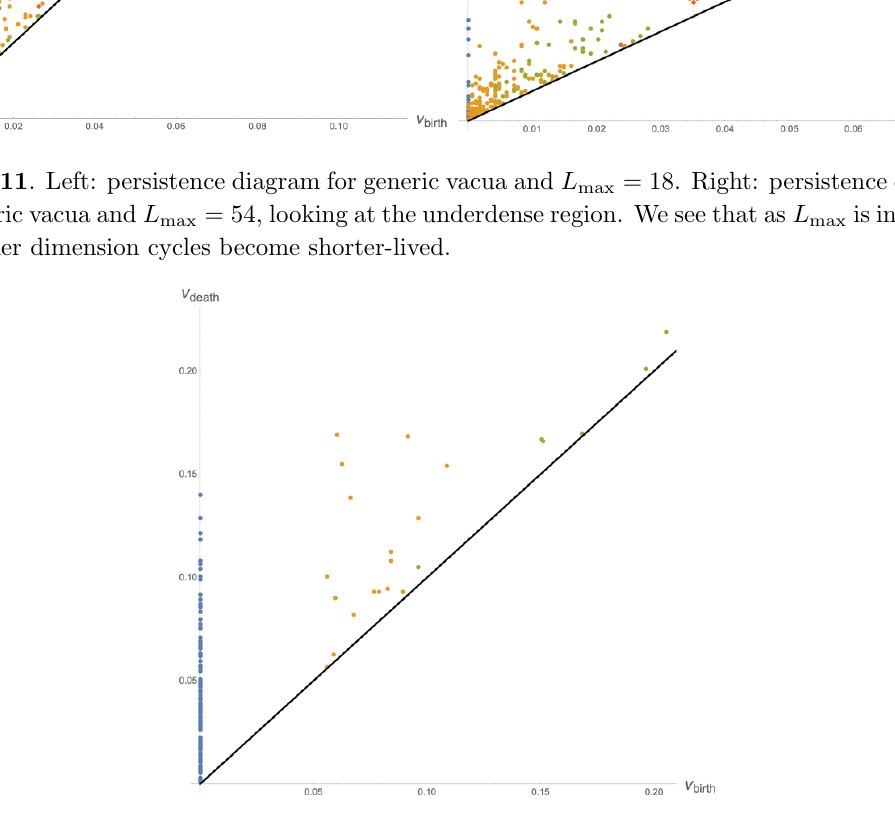
Figure 12 . Long-lived 1-cycles in the generic distribution of T 6 vacua. Here we used 150 landmark points for a subregion of the generic T 6 distribution with L max =